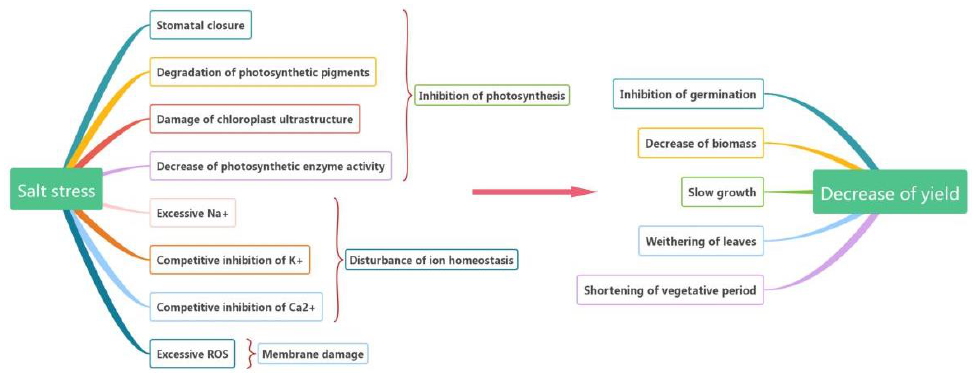
Figure 2. The mechanism of plant salt injury.